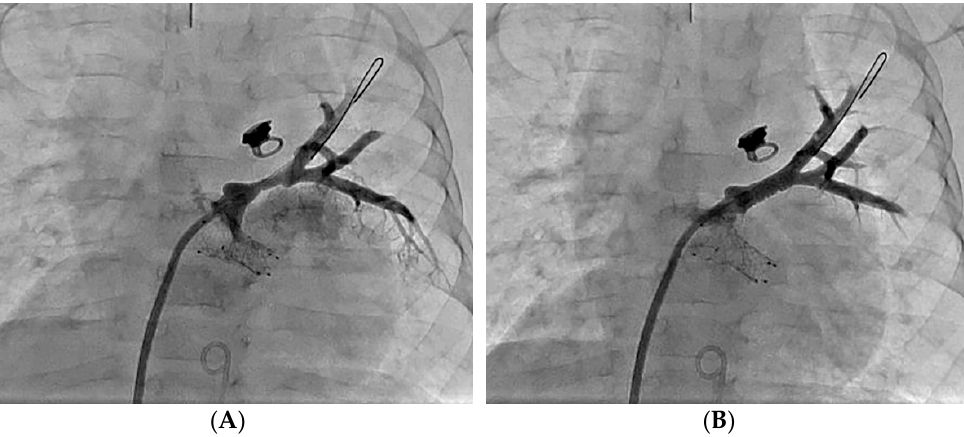
Figure 2. ( A ): Retrograde venography of the left upper pulmonary vein demonstrates proximal stenosis. ( B ): Follow up venography following stent implantation demonstrates improved caliber of the left upper pulmonary vein.